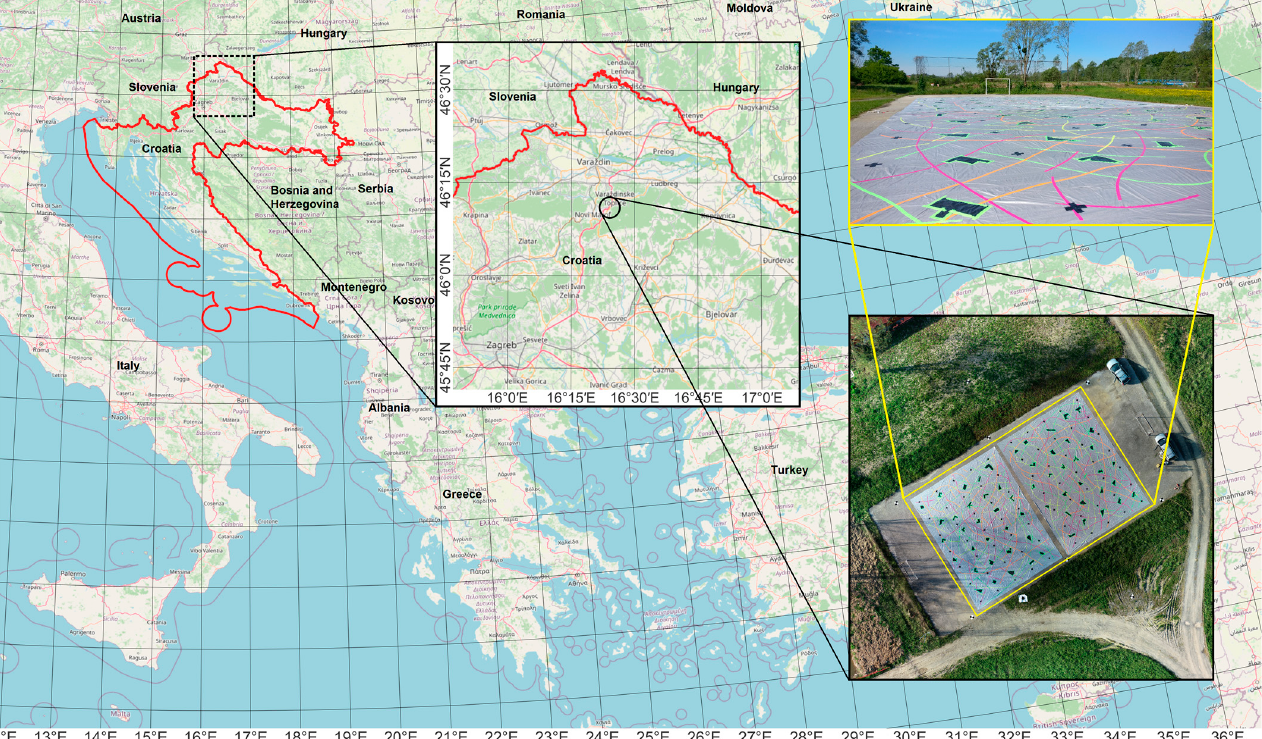
Figure 2. Location of the test field with a simulated landslide.